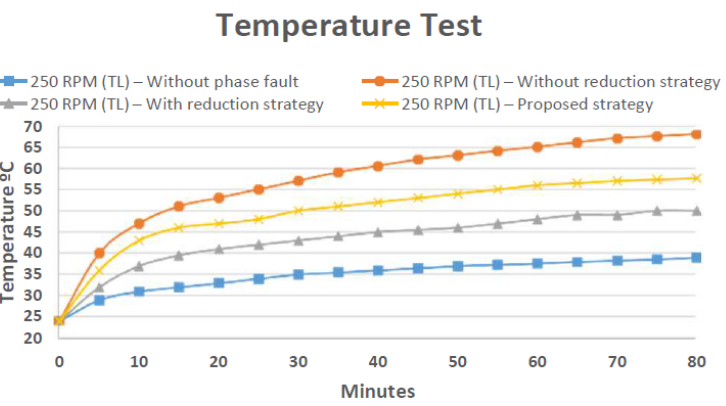
Figure 16. Comparative temperature test of the BLDC motor under the operating modes